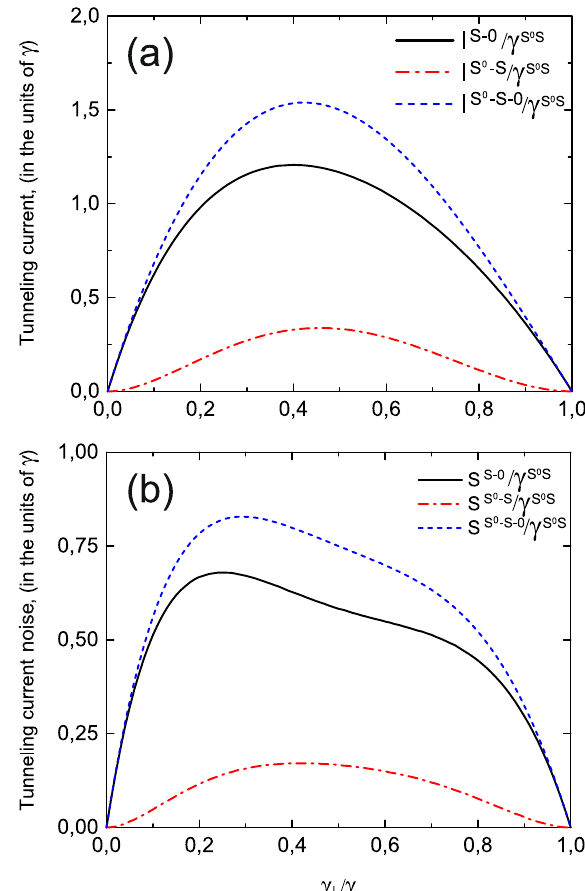
0 /γ S 0 S S S 0 S /γ S 0 S Figure 10. ( a ) Relative contributions I and I to the total tunneling current and total − − 0 /γ S 0 S 0 /γ S 0 S S 0 S S S 0 S /γ S 0 S tunneling current I ; ( b ) Relative contributions S and S to the total noise and − − − − 0 /γ S 0 S S 0 S γ S 0 S L /γ S 0 S and γ S 0 S total noise S as a functions of tunneling contact asymmetry ( γ L /γ − − = 1 . Temperature is equal to 0.01 ε U / T ≫